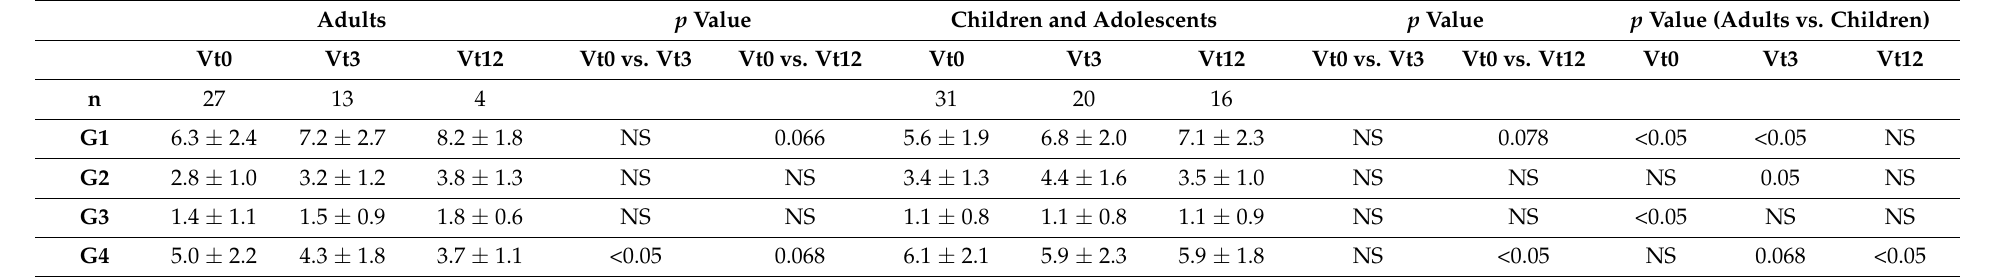
Table 3. Food consumption according to NOVA classification among celiac adults and children (mean of portions/day ± SD).